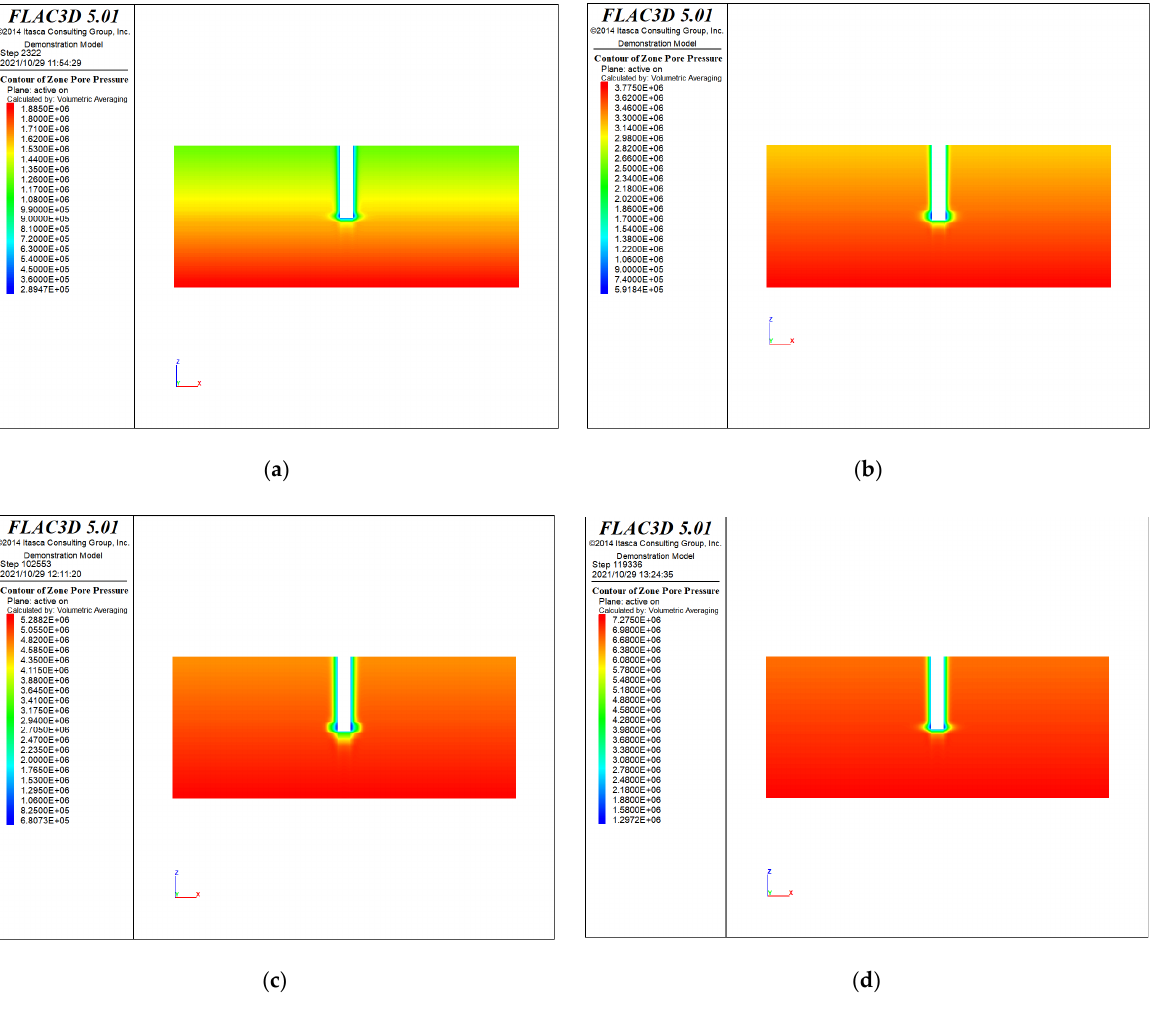
Figure 8. Hydraulic pressure field of different excavation sections with grouting. ( a ) Aq1, ( b ) Aq2, ( c ) Aq3, ( d ) Aq4. Table 6. Comparison of predicted values of different formulas of water